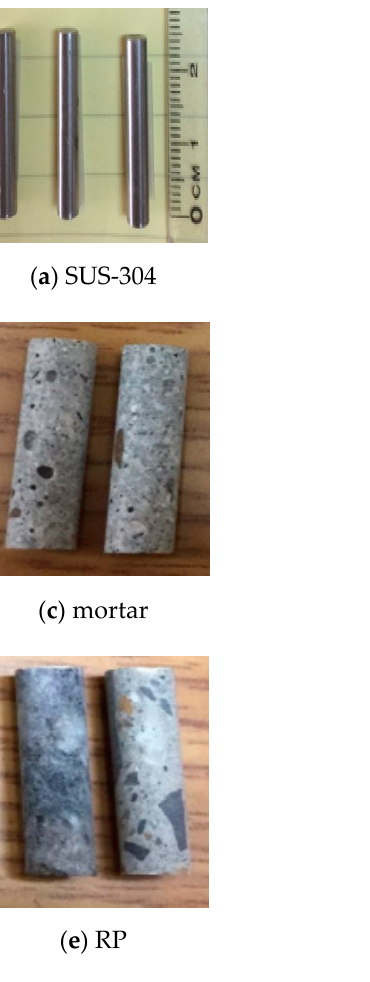
Figure 4. Cylindrical specimens prepared for TMA. Table 3. Basic COTE values measured from the TMA.